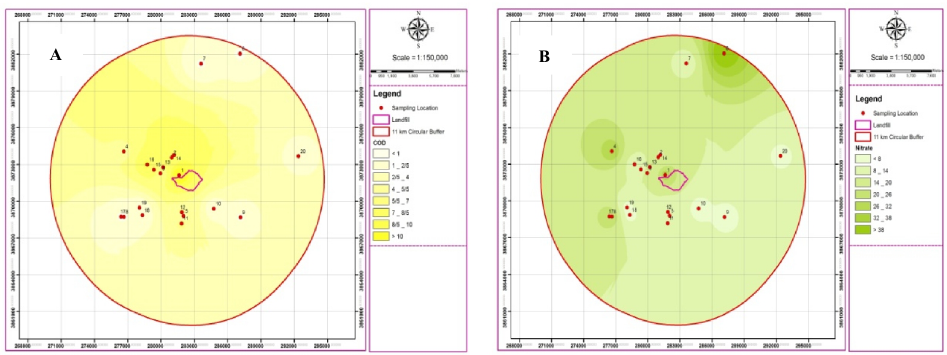
Fig. 5. Spatial Variation of (A) COD, (B) NO 3 in groundwater resources in the study